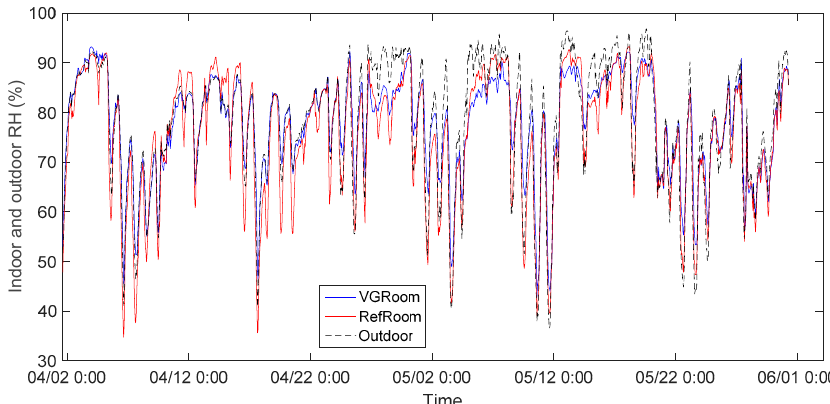
Figure 7. Indoor RH values for the experimental rooms and the outdoor RH.